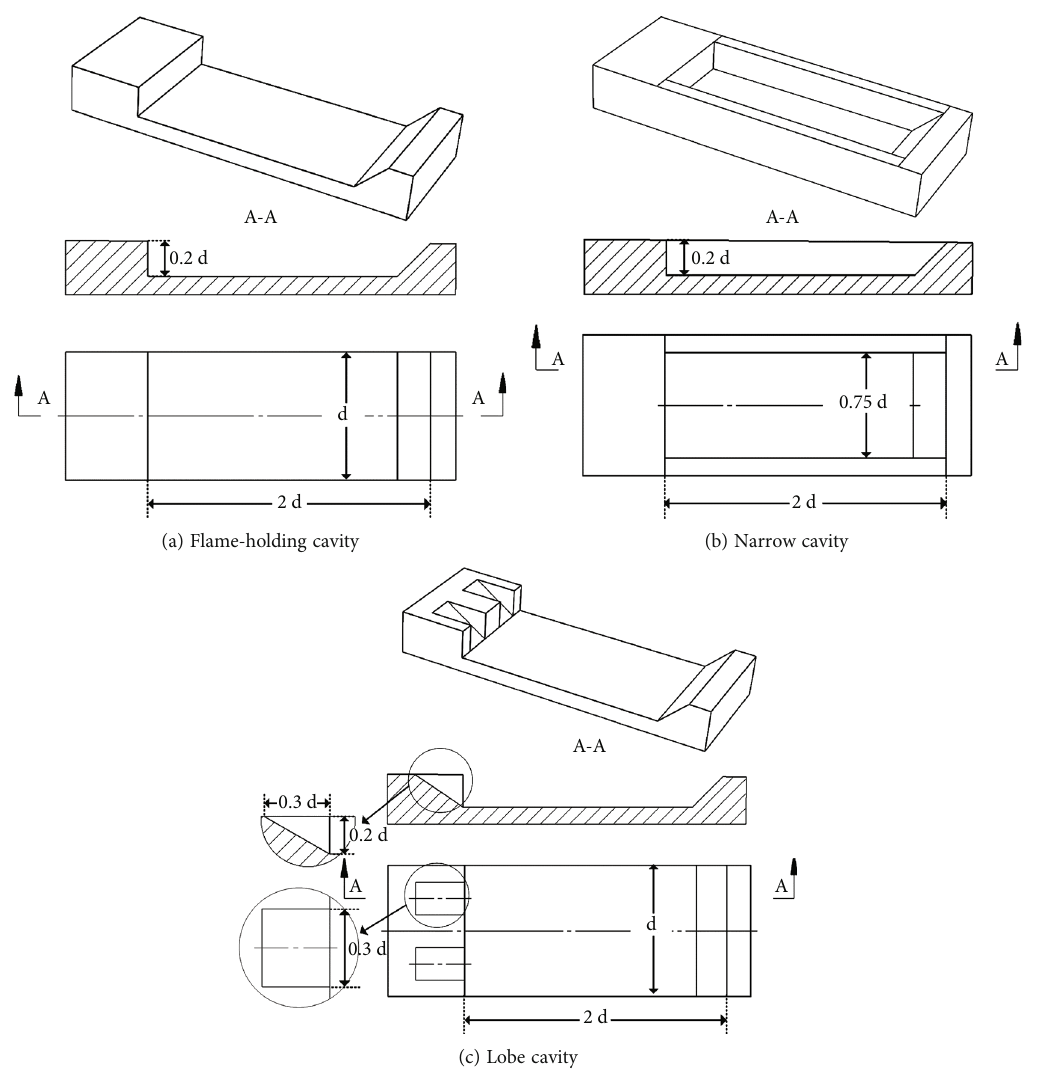
Figure 6: Schematic of the cavity shape.